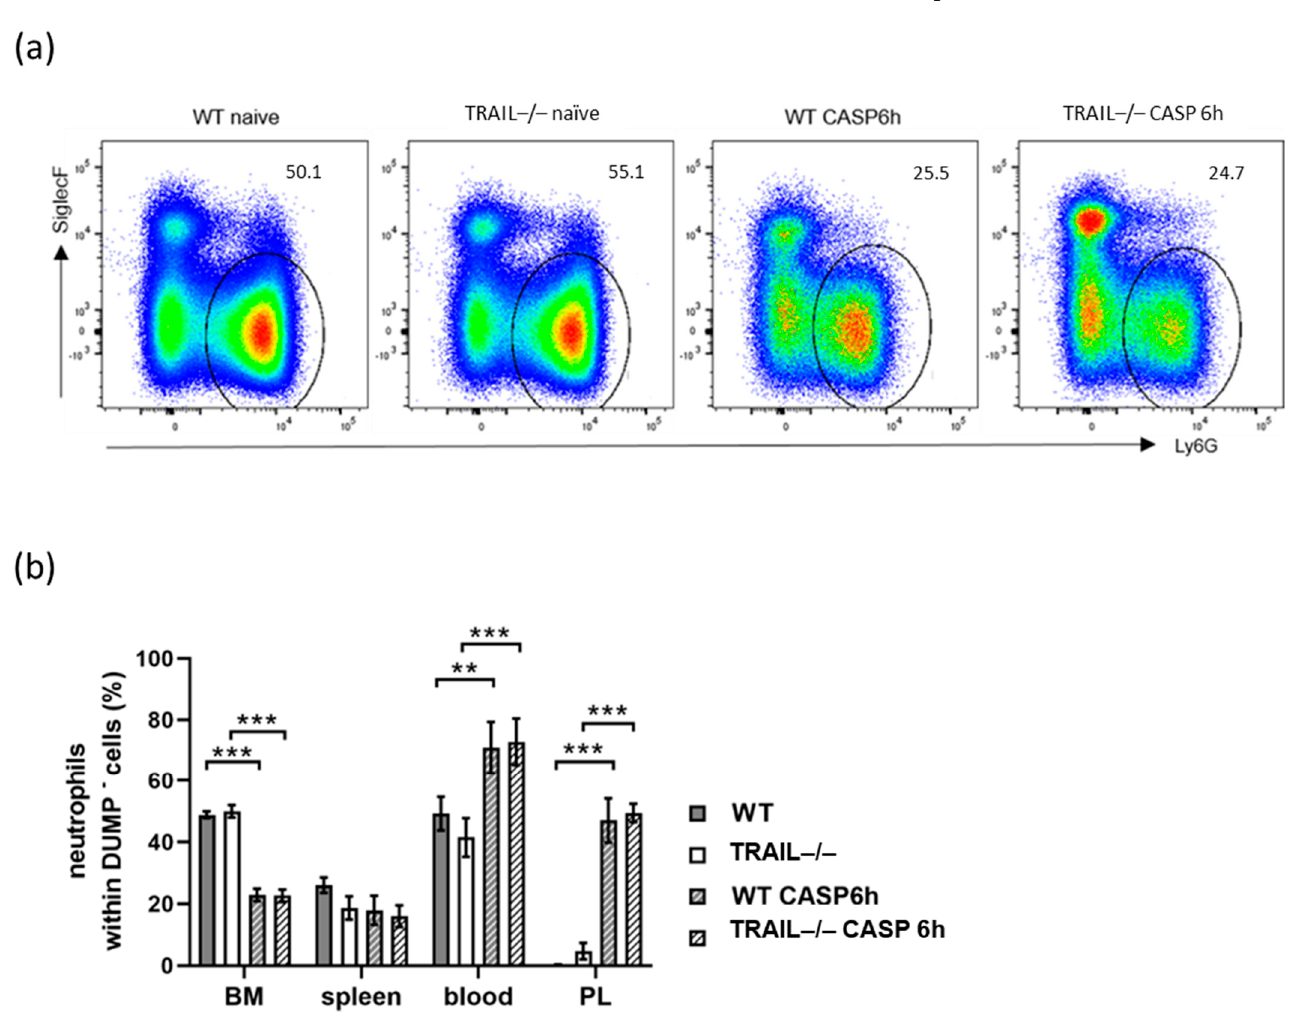
Figure 1. Influence of 6h CASP on the neutrophil ratio in lineage-negative Ly6G cells. ( a ) Representative FACS plots show staining of neutrophils derived from the bone marrow. ( b ) The numbers of neutrophils within DUMP – cells of 5 mice each are shown for bone marrow (BM), spleen, peritoneal lavage (PL), and blood. Neutrophils of septic WT and TRAIL–/– mice were compared with naïve ones. Graphs show mean ± SEM (** p < 0.01, *** p < 0.001).